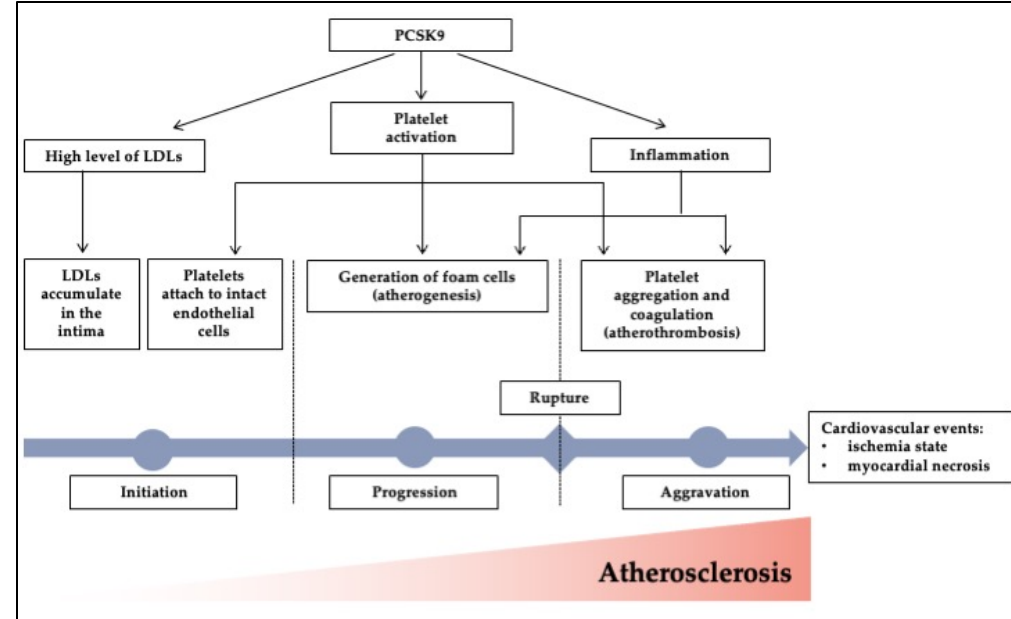
Figure 1. The roles of PCSK9 during atherosclerosis development. PCSK9 promotes an increase in LDL levels, platelet activation, and inflammation, all of which contribute to the progression of atherosclerosis. From initiation, progression, and aggravation, all of the processes work together to accelerate and sustain the progression of cardiovascular disease, which can lead to ischemia and, eventually, an MI event.